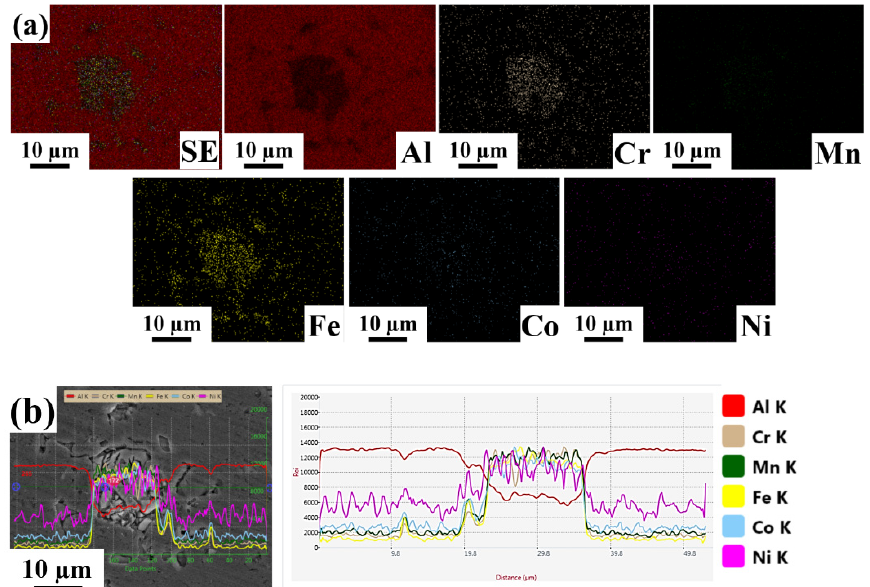
Figure 4. Energy dispersive spectroscopy images of Al 6063–5 wt.% HEA ( a ) Elemental mapping images. ( b ) Line scan image.